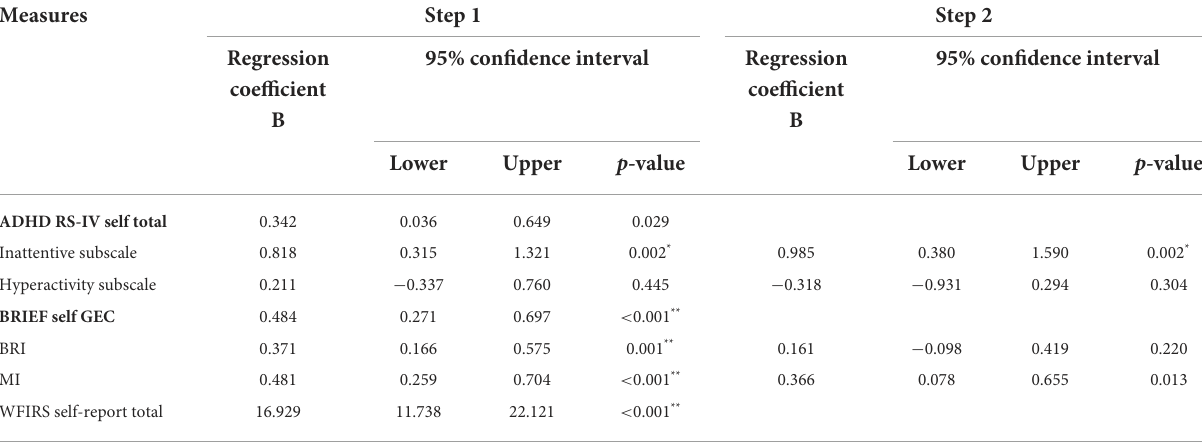
TABLE 3 Results from regression analyses using self-report measures of the ADHD RS-IV, BRIEF and WFIRS measures entered as independent variables in two steps.